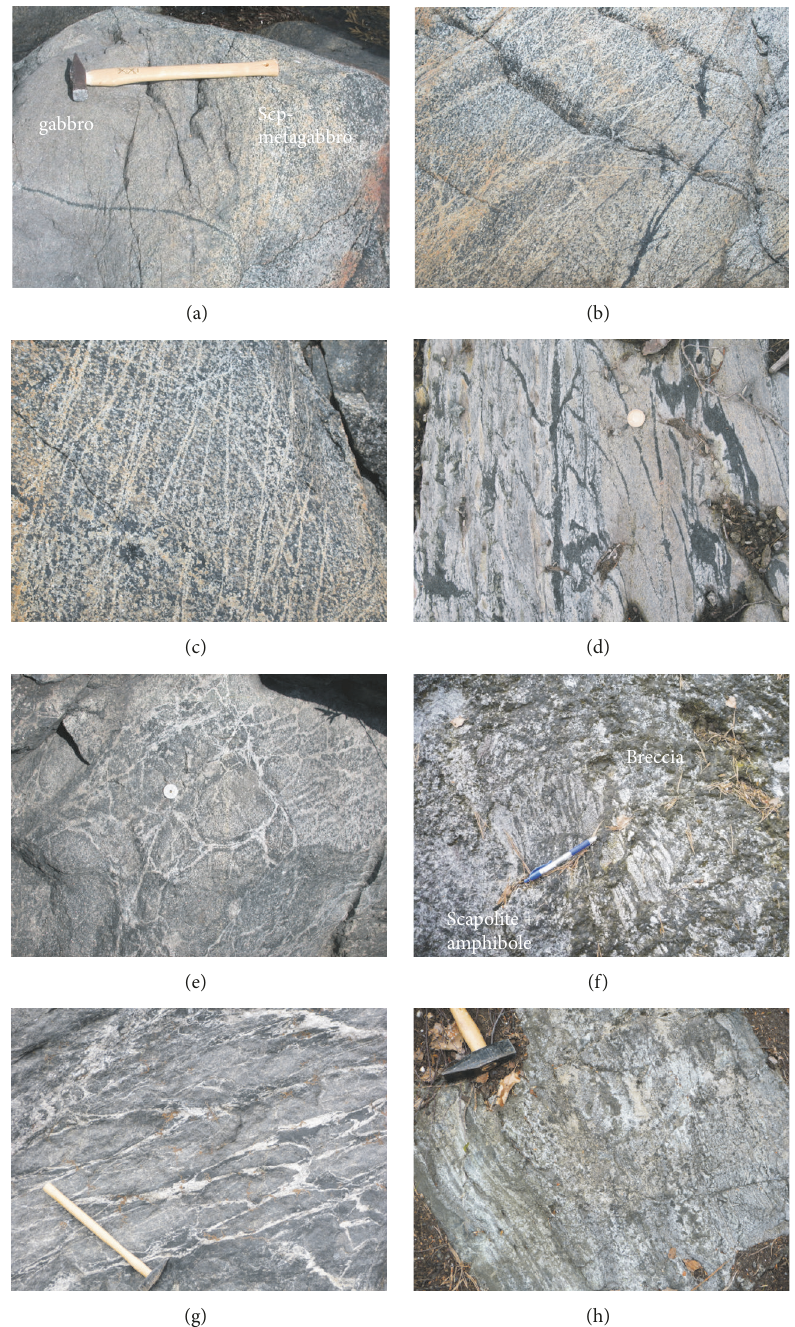
Figure 2: Field photos of scapolite metagabbro and dynamic scapolitisation. (a) Gabbro with scapolitisation front. Locality Langøy. (b) Scapolite metagabbro with veining filled by scapolite and amphibole. Field of view is approximately one metre wide. Locality Langøy. (c) Scapolite metagabbro with a high density of scapolite veining resulting in a layered structure in the rock [20]. Field of view is approximately onemetrewide.LocalityLangøy.(d)Scapolitemetagabbrowithamphiboleveiningandflattenedfoliation[20].LocalityLangøy.(e)Brecciated amphibolite with a thin scapolite vein filling and rounded clasts. Locality ˚Atangen. (f) Intensive scapolitisation of an evolved breccia with amphibole veins, amphibole + scapolite matrix, and rounded clasts. Locality ˚Atangen. (g) Brecciated amphibolite with scapolite veins undergoing flattening. Locality ˚ Atangen. (h) Foliated scapolite-bearing amphibolites. Locality ˚